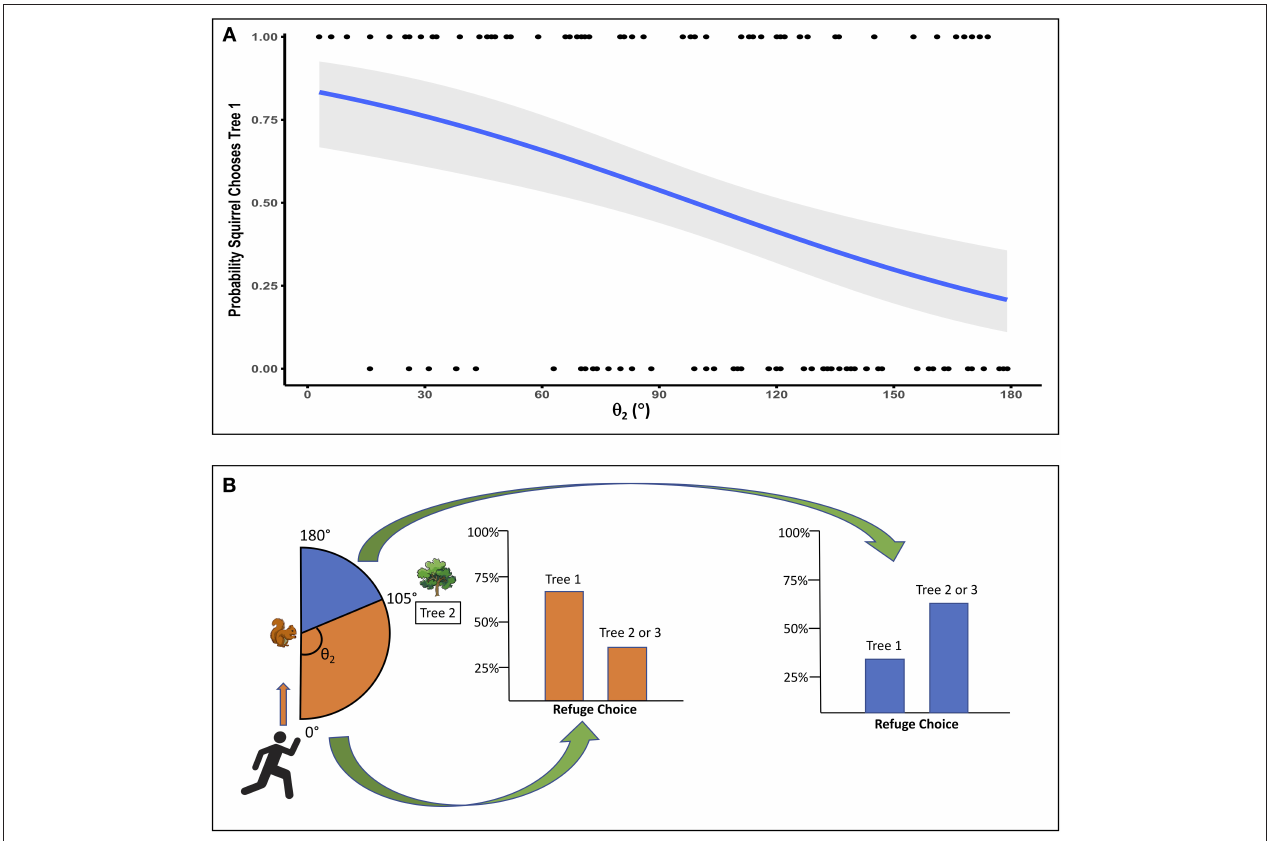
FIGURE 3 | (A) As θ 2 increases, Tree 2 becomes a more attractive (less risky) refuge, and the probability that a squirrel will choose Tree 1 decreases. However, a relatively large angle for Tree 2 ( θ 2 ≥ 105 ◦ ) is required to make the probability of choosing Tree 1 ≤ 0.5. Gray area indicates SE, and dots show squirrel refuge choices, with a value of 1 for a squirrel that chose Tree 1 and a value of 0 for a squirrel that chose Tree 2 or Tree 3. (B) Squirrels were less likely to select Tree 1 as a refuge when θ 2 was relatively large, making the flight trajectory to Tree 2 less risky. When Tree 2 angle ( θ 2 ) was ≤ 105 ◦ , 67% of squirrels chose Tree 1 and 33% chose Tree 2 or 3. When θ 2 was > 105 ◦ , 33% of squirrels chose Tree 1 and 67% chose Tree 2 or